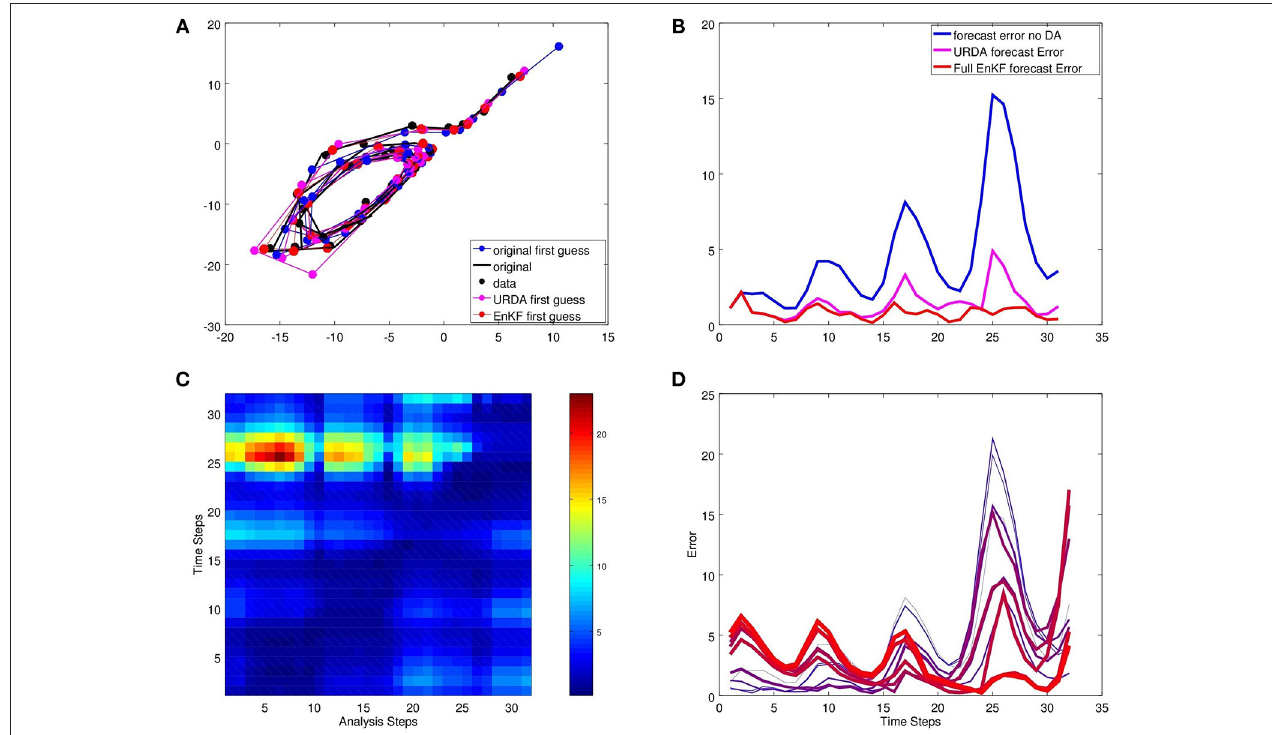
FIGURE 3 | Studying the results of the ultra-rapid ensemble smoother over N 32 assimilation steps. (A) shows the original data and the first guess of the Kalman = filter analysis cycle. The corresponding first guess error is compared in (B) . (C,D) show the error of the full ultra-rapid ensemble analysis for the full time-scale between t 0 and t N for N 32 time steps. In (D) we display the error for the curves t 1 , t 4 , t 7 ,..., t 3 1, starting with a thin blue curve and ending with a thick red curve. =